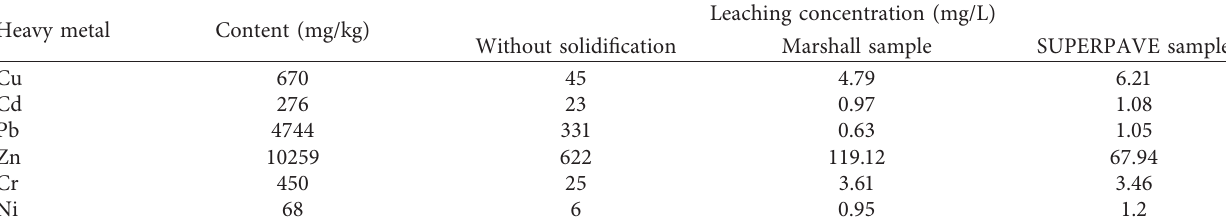
Table 6: Leaching concentration of fly ash after asphalt